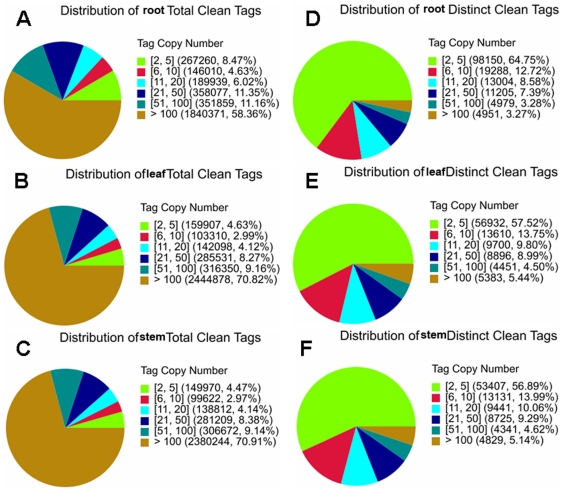
Distribution of total tags and distinct tags over different tag abundance categories.Distribution of the total clean tags in the root (A), leaf (B), and stem (C). Numbers in the square brackets indicate the range of copy numbers for a specific category of tags. For example, [2], [5] means all the tags in this category has 2 to 5 copies. Numbers in the parentheses show the total tag copy number for all the tags in that category. Distribution of the distinct clean tags in the root (D), leaf (E), and stem (F). Numbers in the square brackets indicate the range of copy numbers for a specific category of tags. Numbers in the parentheses show the total types of tags in that category.